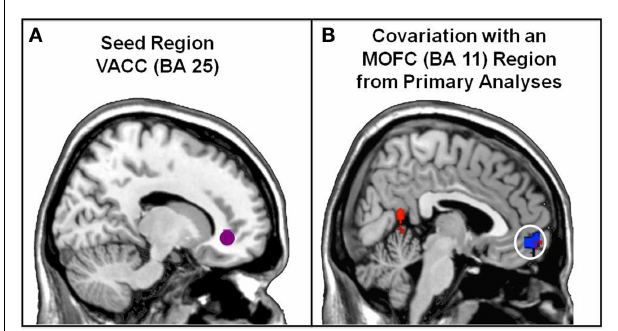
FIGURE 2 | PPI connectivity analyses for theVACC seed associated with social comparisons about Positive (i.e., desirable) vs. Negative (i.e., undesirable) personality traits . (A) Each participant’s time series was extracted from theVACC seed (5mm radius sphere around group peak: 14, 38, − 4 from the Positive vs. Negative contrast, Beer and Hughes, 2010). (B) TheVACC seed shows relatively more positive covariation with an MOFC region.This MOFC region overlaps with the MOFC region that regulates the extent to which social comparisons are positively tinged (red: MOFC region found in PPI analyses; blue: MOFC region found in Beer and Hughes, 2010; purple: overlap between MOFC region in connectivity and primary